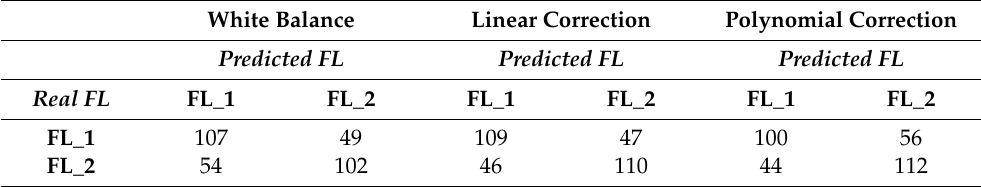
Table 6. The table shows the Confusion Matrices obtained by the classification working on distin- guishing the different fertilization levels (FL_1 vs. FL_2) using the timer-based irrigation management from datasets provided by the three different color correction